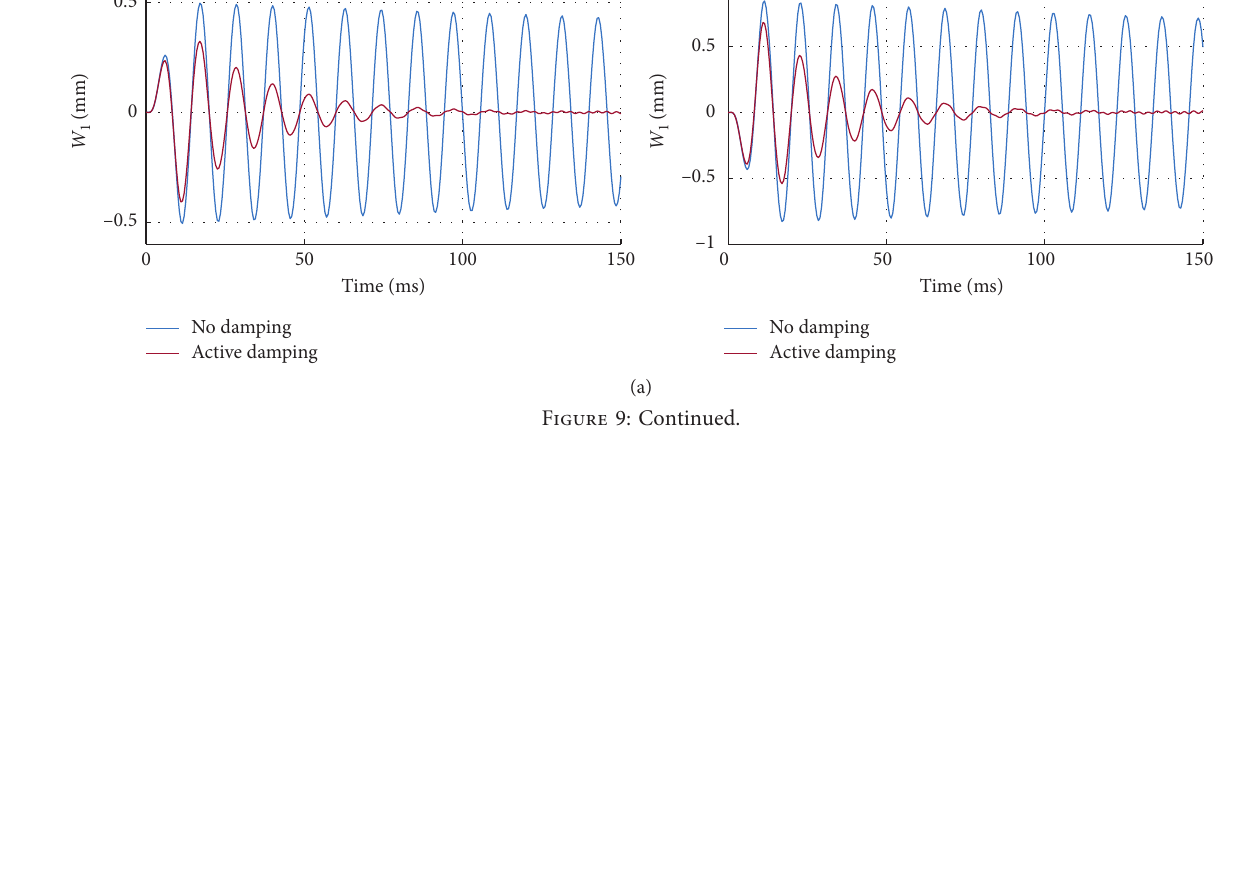
Figure 8: Accelerated trajectories (1 st , 2 nd , and 3 rd trajectories move 2mm, 4 mm, and 8mm within 10msec).